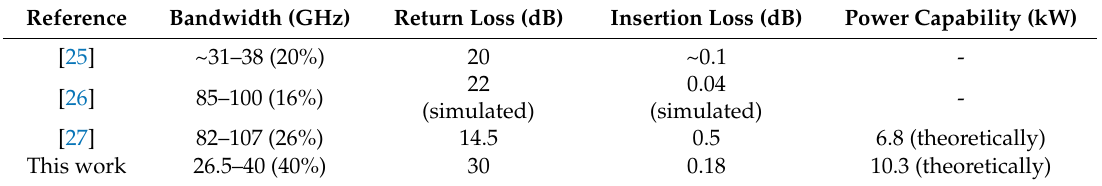
Table 3. Performance comparison between turnstile-based power